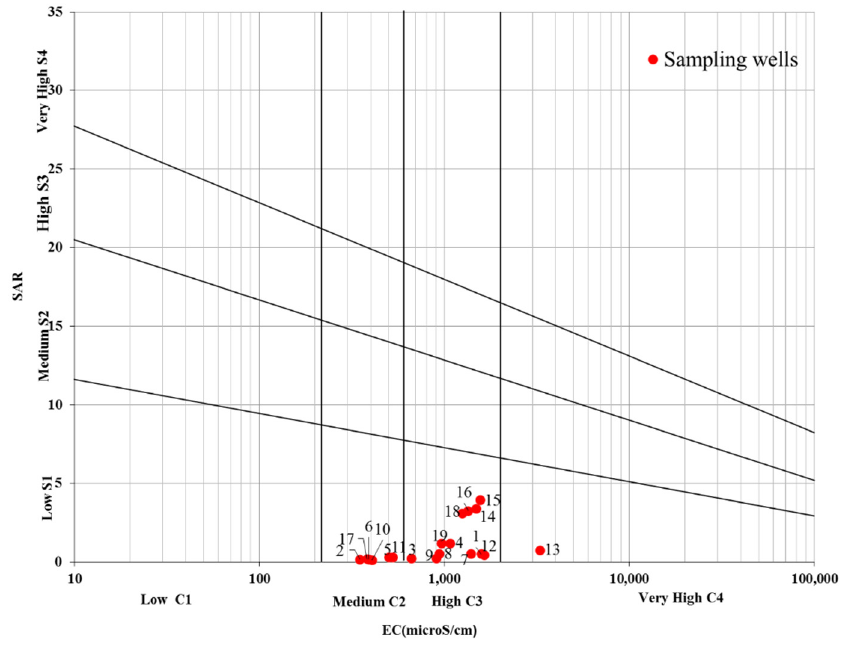
Figure 3. Wilcox log diagram of groundwater for the Imam Zadeh Jafar Aquifer.